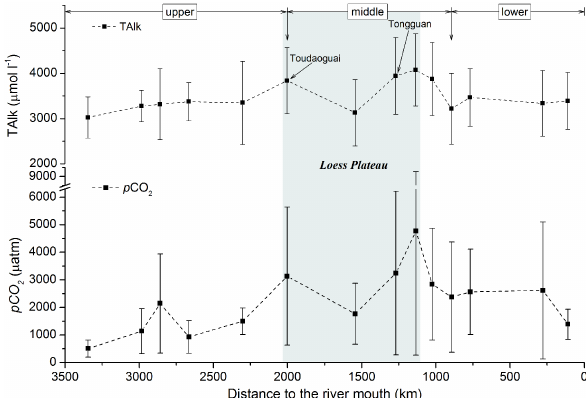
Figure 5. Longitudinal variations of TAlk and p CO 2 along the mainstem channel. The shaded region approximately represents the Loess Plateau. Whiskers indicate the standard